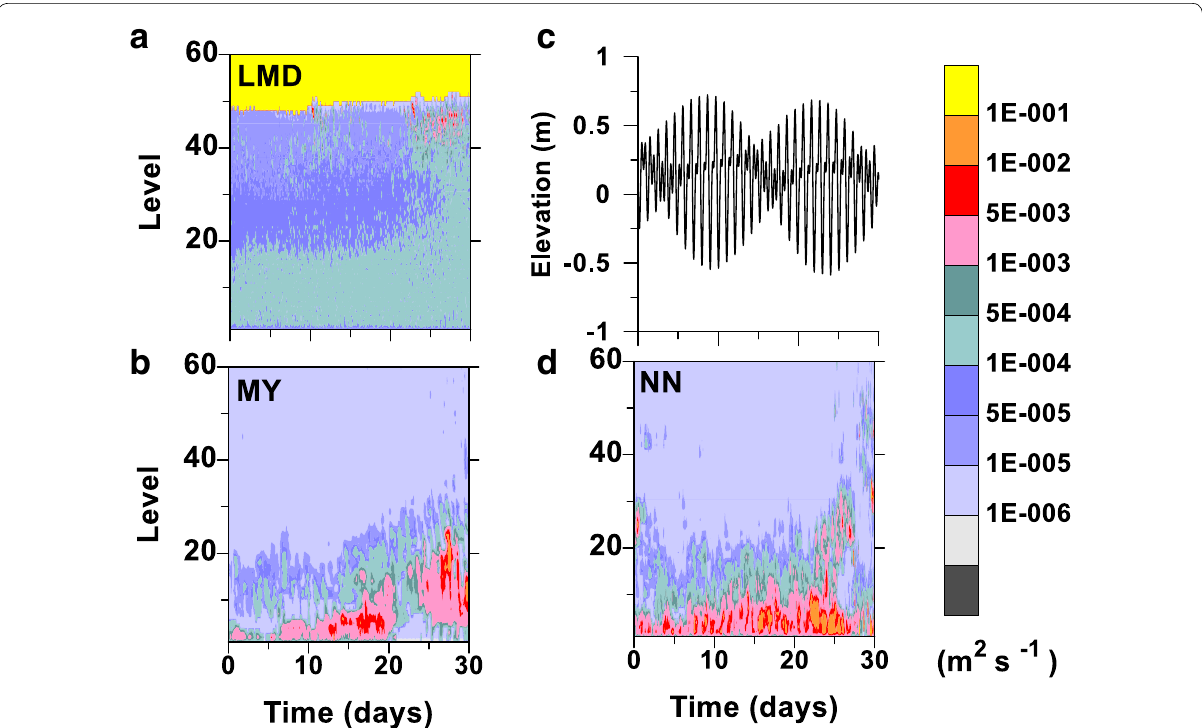
Fig. 7 Time series of the vertical temperature diffusivities over the crest of the guyot using the a LMD, b MY, and d NN vertical mixing parameterizations. c Time series of the elevations to indicate the daily and spring-neap tidal cycles. From level 1 to 60, the depths for the rho and horizontal velocities rounded to the nearest m at this location are: 492., 484., 474., 465., 454., 445., 433., 422., 411., 399., 387., 376., 364., 352., 340., 328., 316., 304., 292., 281., 269., 258., 247., 236., 225., 214., 204., 193., 183., 174., 164., 155., 146., 137., 129., 121., 113., 105., 98., 91., 84., 78., 71., 65., 60., 54., 49.,